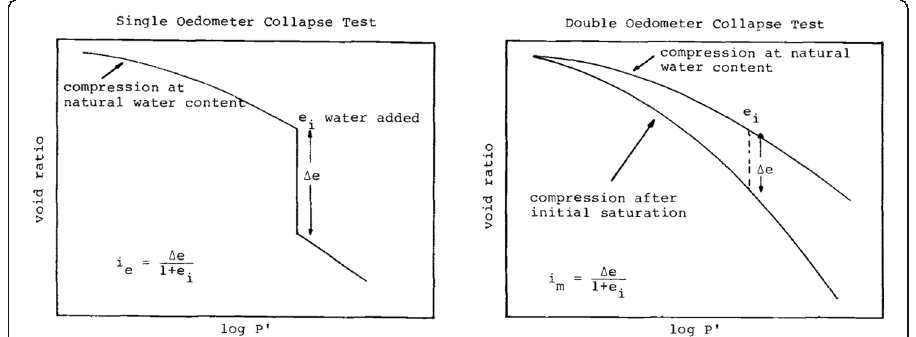
Fig. 11 Predicting collapse using single and double oedometer procedures (after Lutenegger and Hallberg